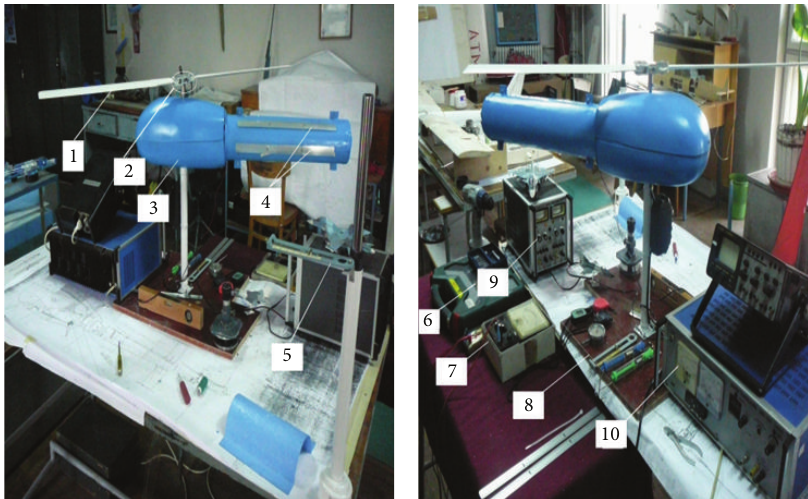
Figure 9: Experimental device: 1: NOTAR helicopter blades carbon fiber, 2: hub pitch, 3: structure helicopter fiberglass, 4: Coand˘a slots, 5: device measuring dynamometer force 𝐹 , 6: tool kit with, 7: measuring and control equipment, 8: instruments for making measurements (timer, dynamometers, Anemometers electronic, mechanical comparator, and roulette), 9: dual source DC power, and 10: stabilized power source and electronic